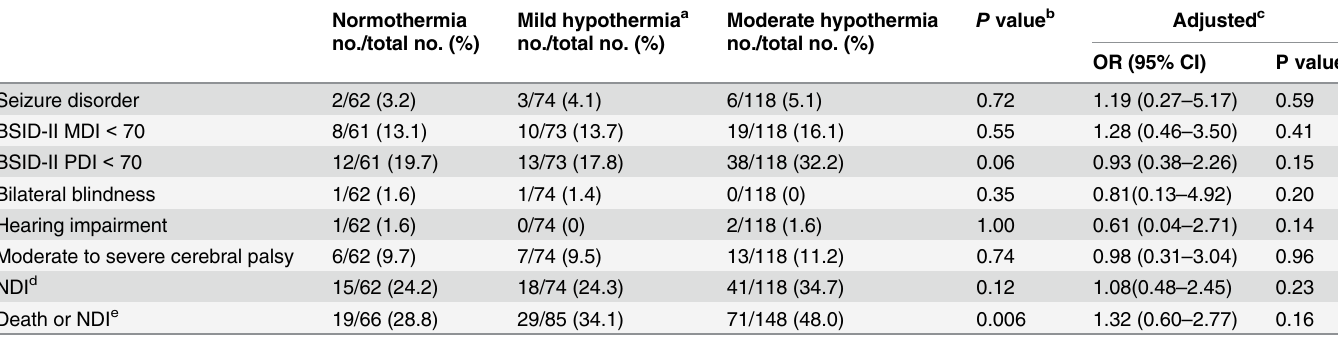
Table 3. Long-term outcomes between